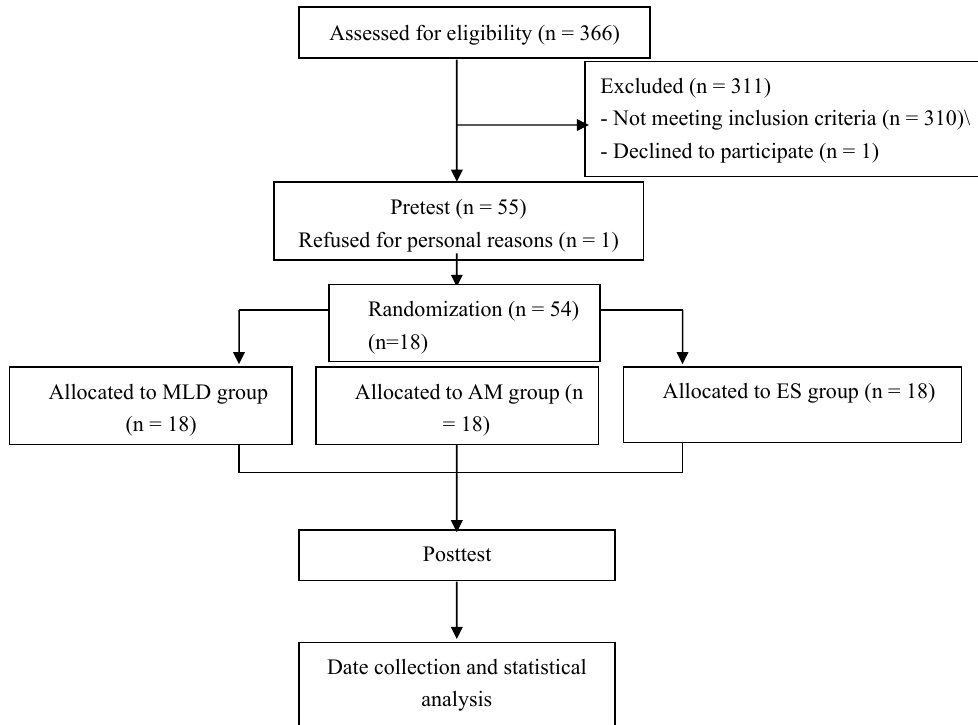
Figure 1. Experimental procedures time flow chart. MLD: manual lymph drainage, AM: abdominal massage, ES: electrical